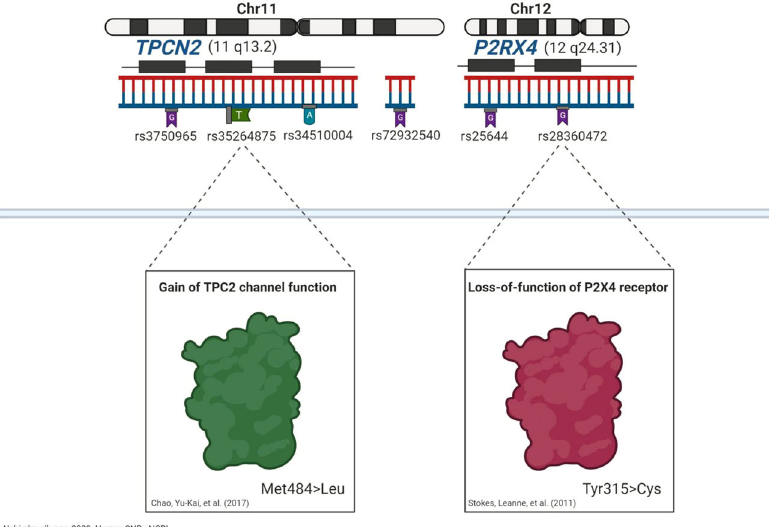
Fig. 1 Schematic representation of genetic polymorphisms in endolysosomal ion channels TPC2 and P2RX4 that are included in our analysis. (The fi gure was created with